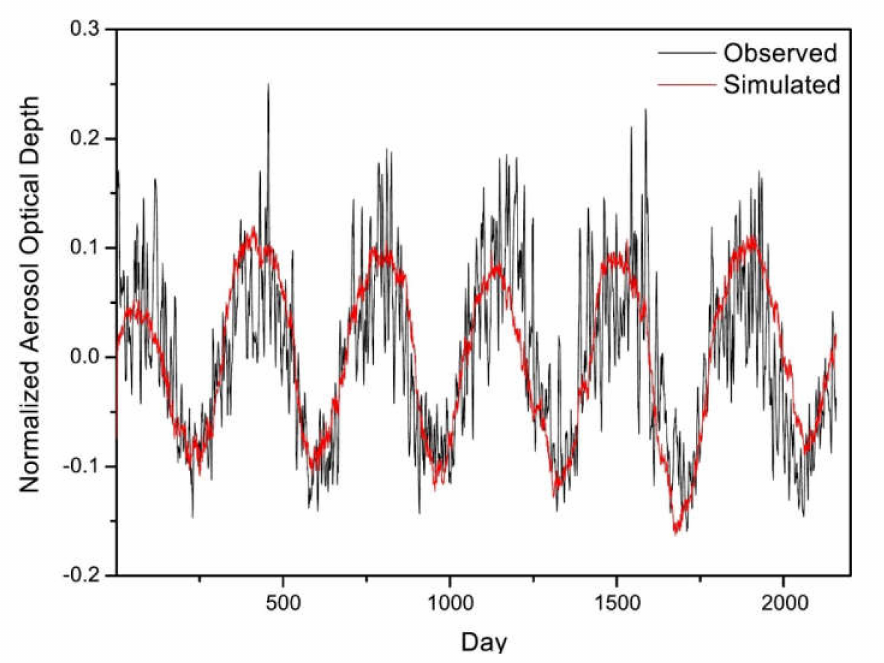
Figure 6. Comparison between simulated (red line) and experimental data (black line). Performing numerical simulations, the best fit with data under the constraints of Equation (3) leads to A = 10 − 3 and ν ≈ 0.03 at